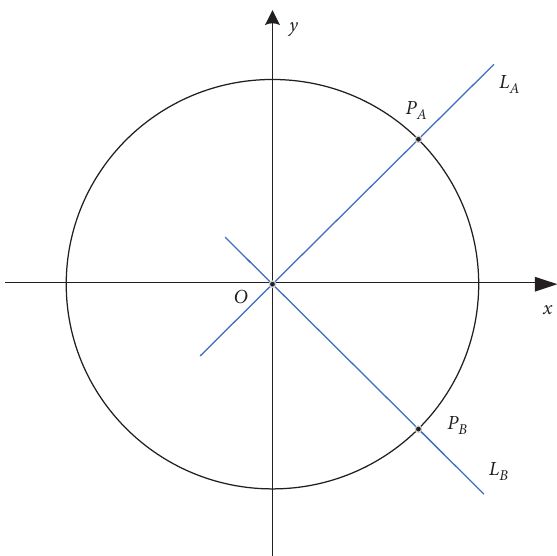
Figure 3: Gradient Hough